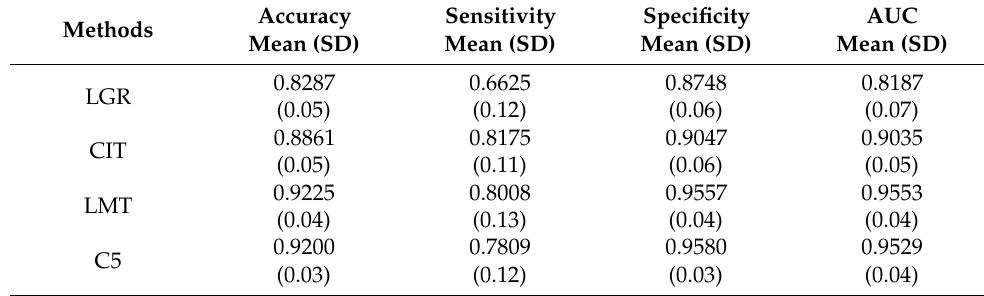
Table 4. Model performance of all methods for moderate glaucoma